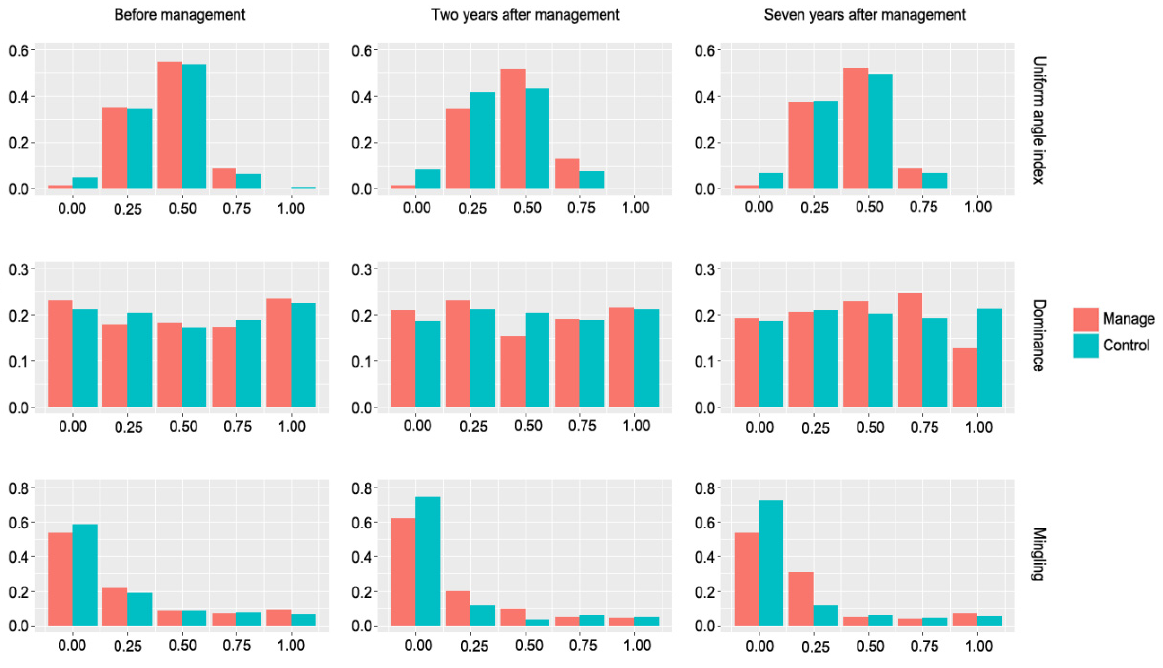
Figure 3. Frequency distributions of SSSPs at different management years.